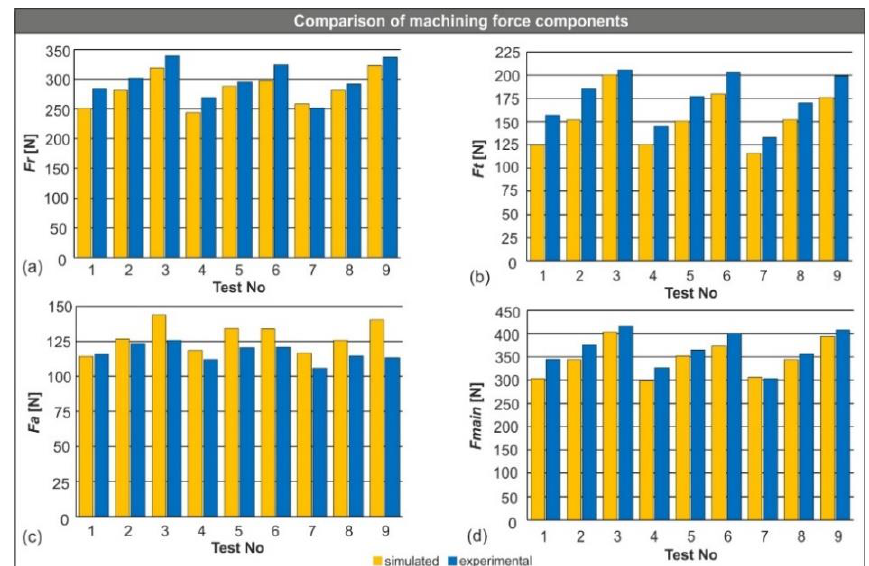
Figure 9. Simulated versus experimental machining force components: ( a ) the radial force, ( b ) the tangential force, ( c ) the feed force and ( d ) the resultant machining force.